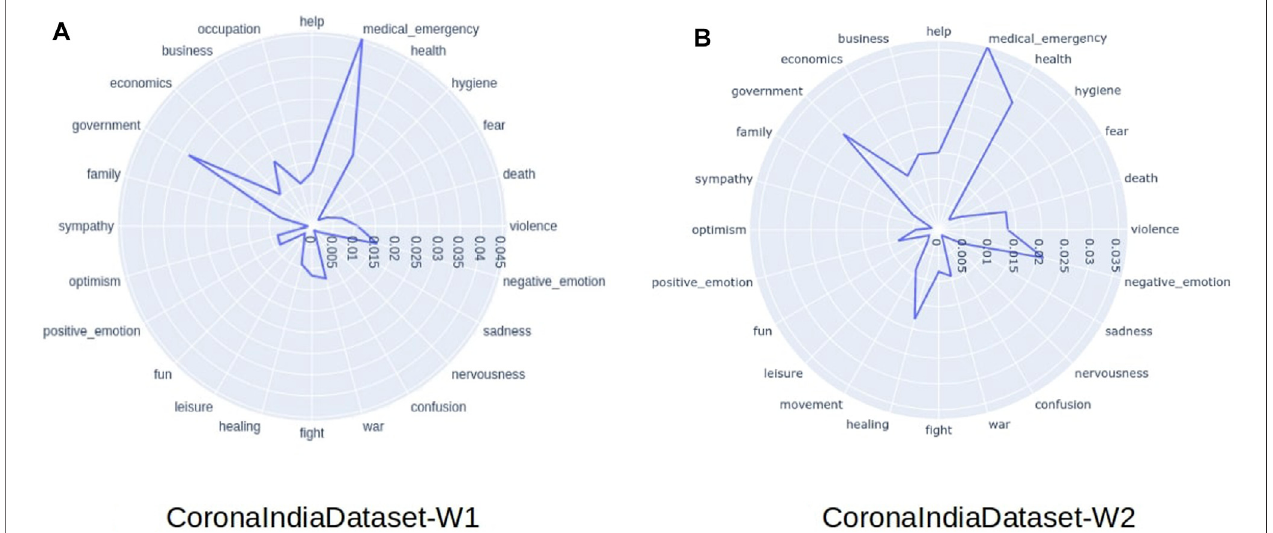
FIGURE 3 | Empath Analysis for Indian Twitter in both waves. medical_emergency is the most frequently talked about Empath category. The main difference between the two waves is that the “ help ” and “ death ” categories are much more prominent in the second wave.